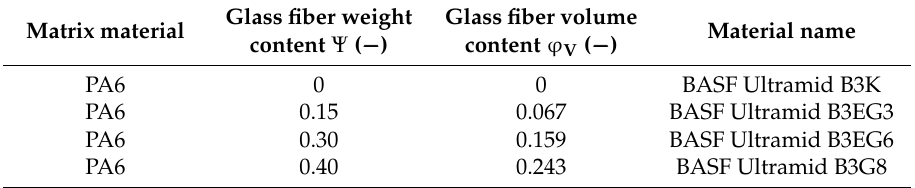
Table 1. Investigated materials from BASF SE, Ludwigshafen (Germany) [17].